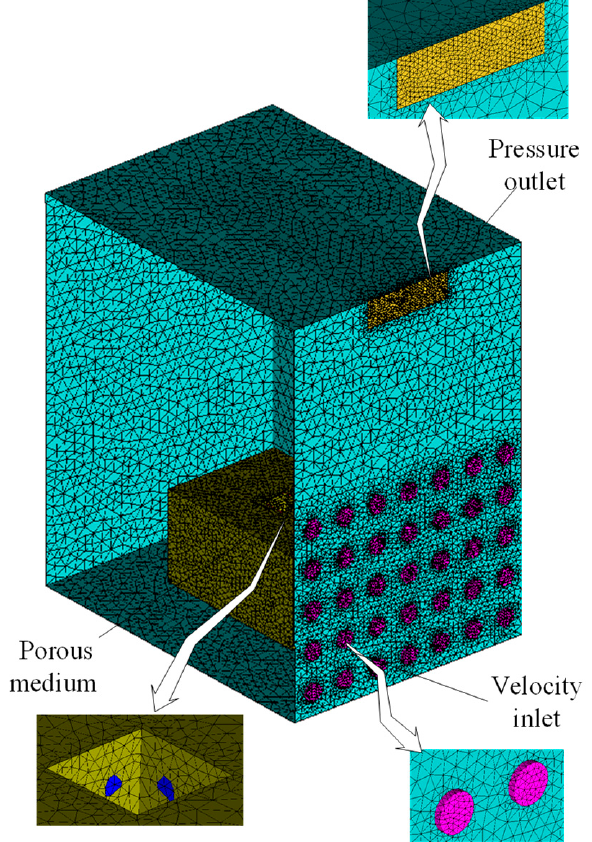
Figure 6. Mesh Figure 6. Mesh model.